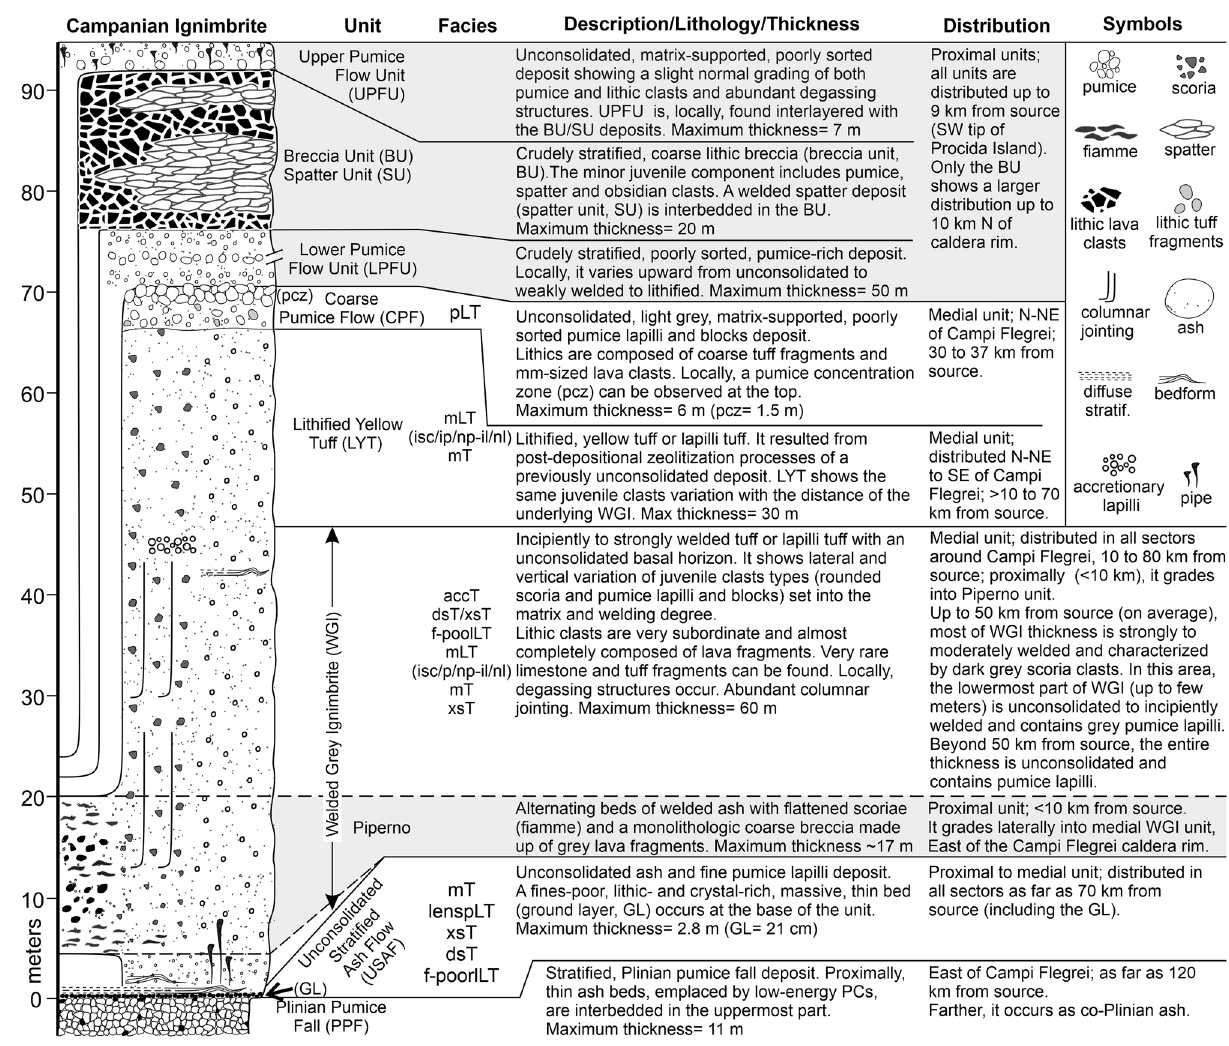
Figure 2. Composed stratigraphic section of the Campanian Ignimbrite with summary of the main characteristics of the recognized units. Grey shaded area (plus the ubiquitous unconsolidated stratified ash flow deposit) indicates the units forming the proximal Breccia Museo. Facies abbreviation: f-poorlLT (fines-poor lithic lapilli tuff); mT or mLT (massive tuff or massive lapilli tuff), isc/ip (inverse graded scoria/pumice), np (normal graded pumice), il/nl (inverse/normal graded lithic); dsT (diffuse stratified tuff); xsT (cross stratified tuff), pLT (pumice lapilli tuff); lenspLT (lenses of pumice lapilli tuff); accT (accretionary lapilli-bearing). Figure is generated using CorelDRAW Graphics Suite 2020 for Windows v. 22.0.0.412 (https ://www.corel draw.com/it/ produ ct/corel